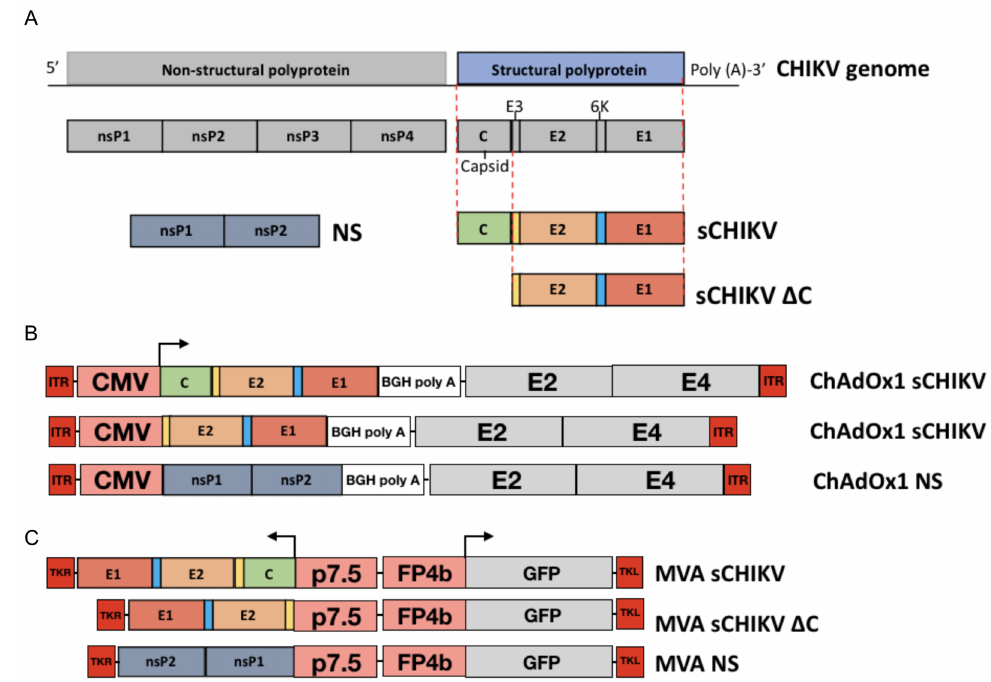
Figure 2. Genome organisation of CHIKV and generation of vaccine candidates. ( A ) Schematic figure of the full genomic RNA of CHIKV depicting the non-structural and structural coding